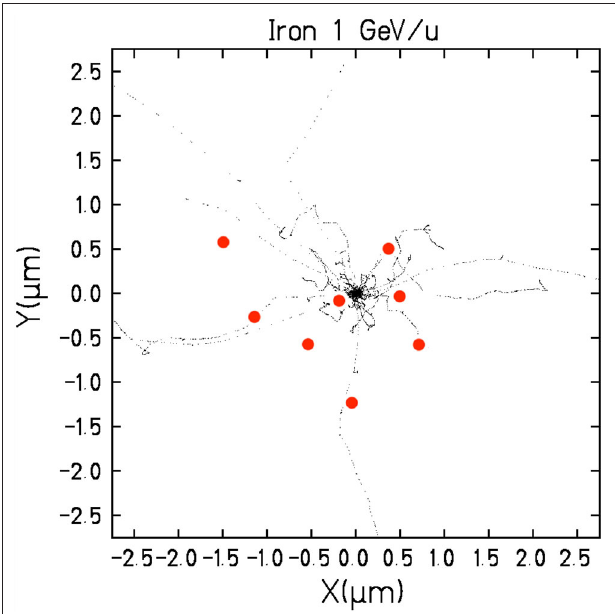
FIGURE 4 | Track structure and virus. Simulation with the TRAX Monte Carlo code of a 1 GeV/n 56 Fe-ions in water. Each black dot represents an ionization event. The track is seen exiting from the plane in bird’s eye view. Axes are spatial coordinates in µ m from the track center. The red spheres give the approximate size of the coronavirus.